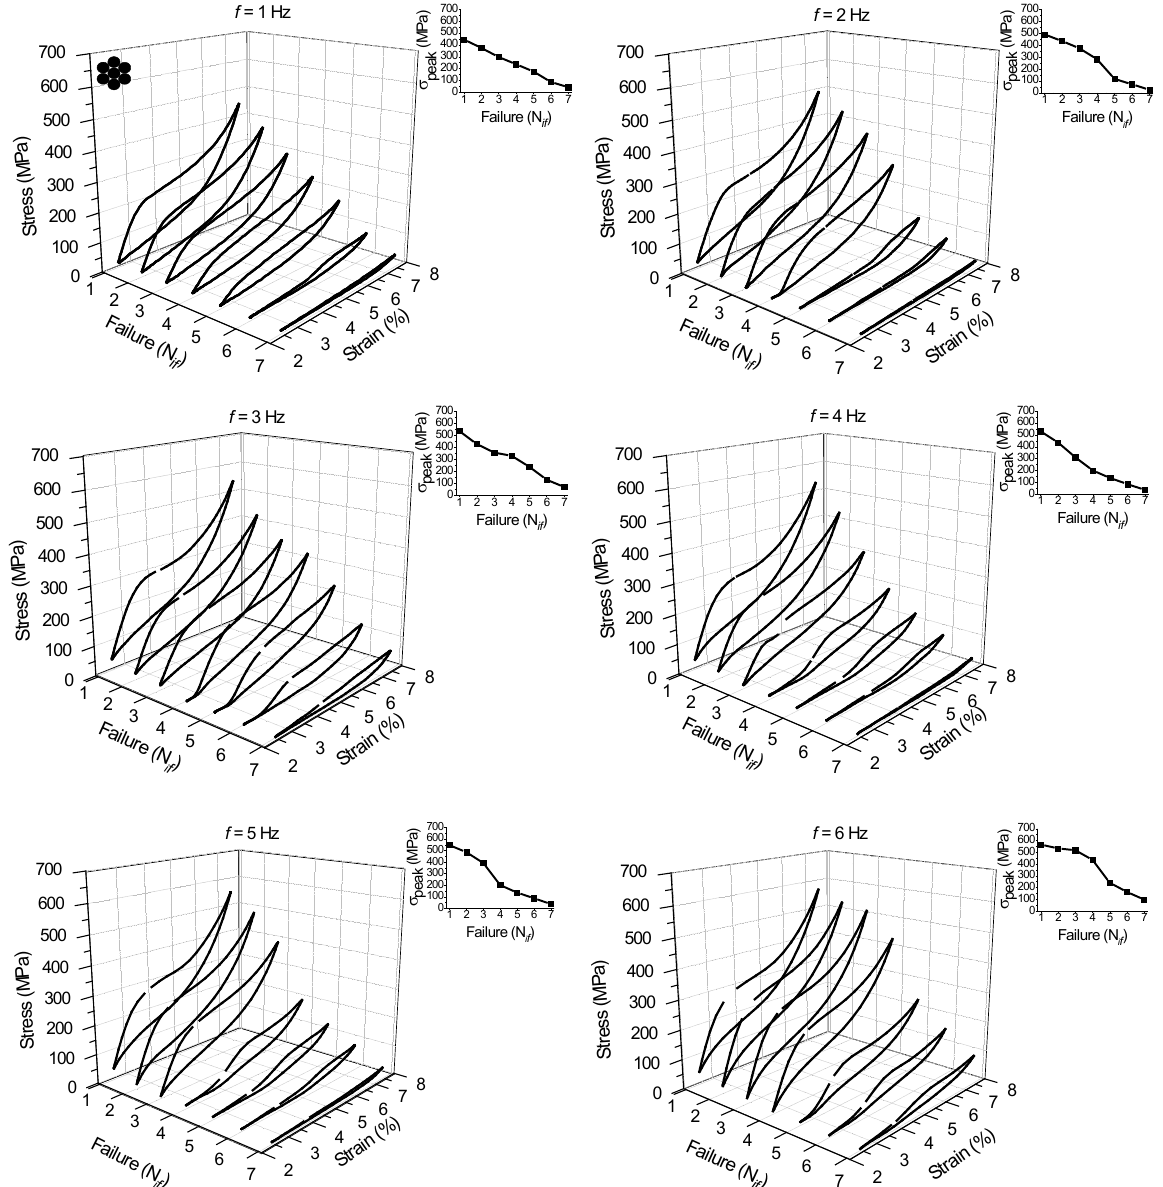
Figure 15. Stress vs. strain superelastic response immediately prior to the failure of the filaments of the SMA NiTi micro cable from 1 Hz to 6 Hz.